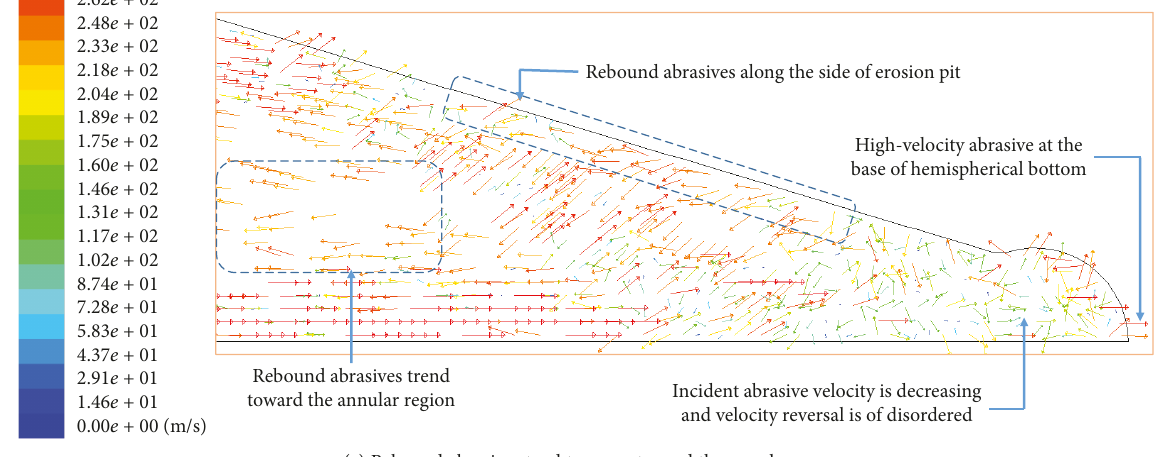
Figure 9: Abrasive distribution and motion direction of the abrasive during rock erosion by the abrasive gas